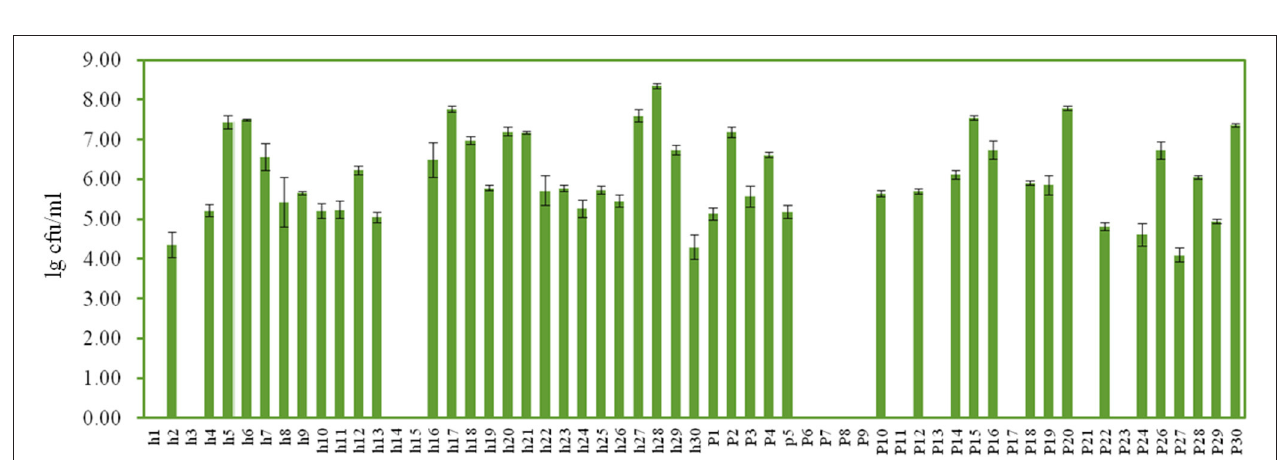
FIGURE 7 | Enumeration of yeasts in the Suanzhou